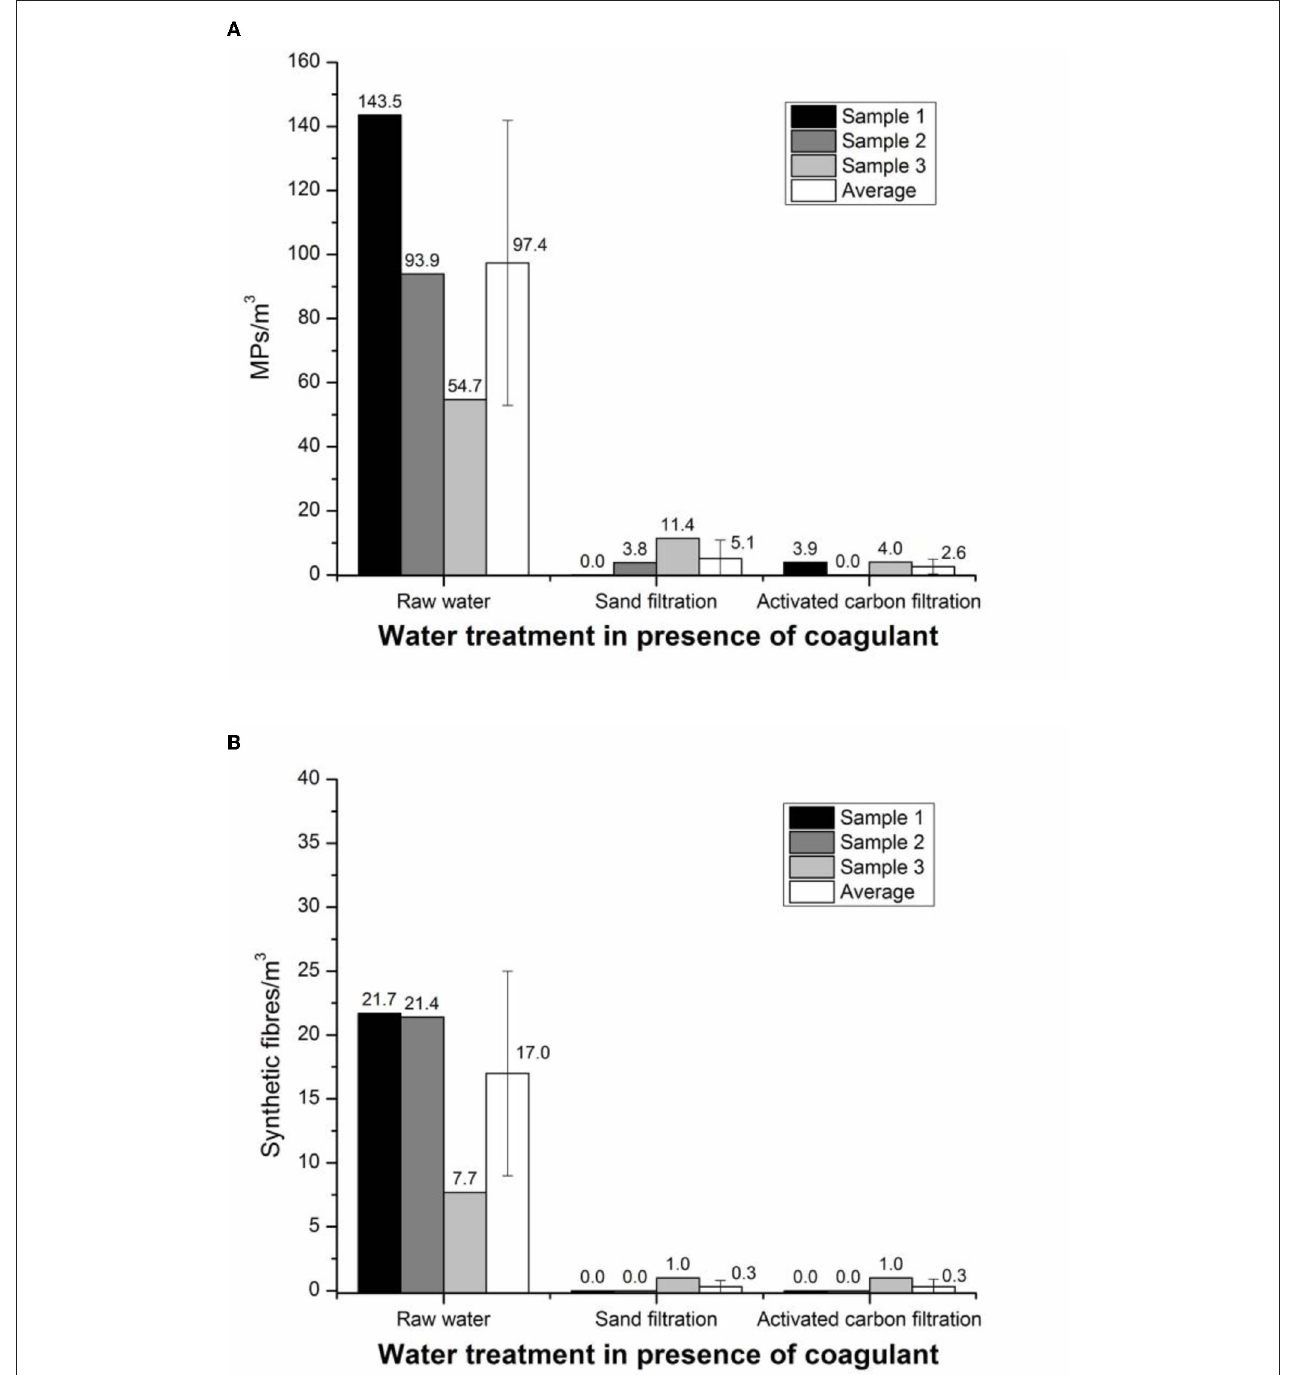
FIGURE 2 | Concentration of MPs (A) and synthetic fibres (B) in raw water, after sand filtration and after activated carbon filtration in presence of coagulant of each sampling and average with standard deviation.